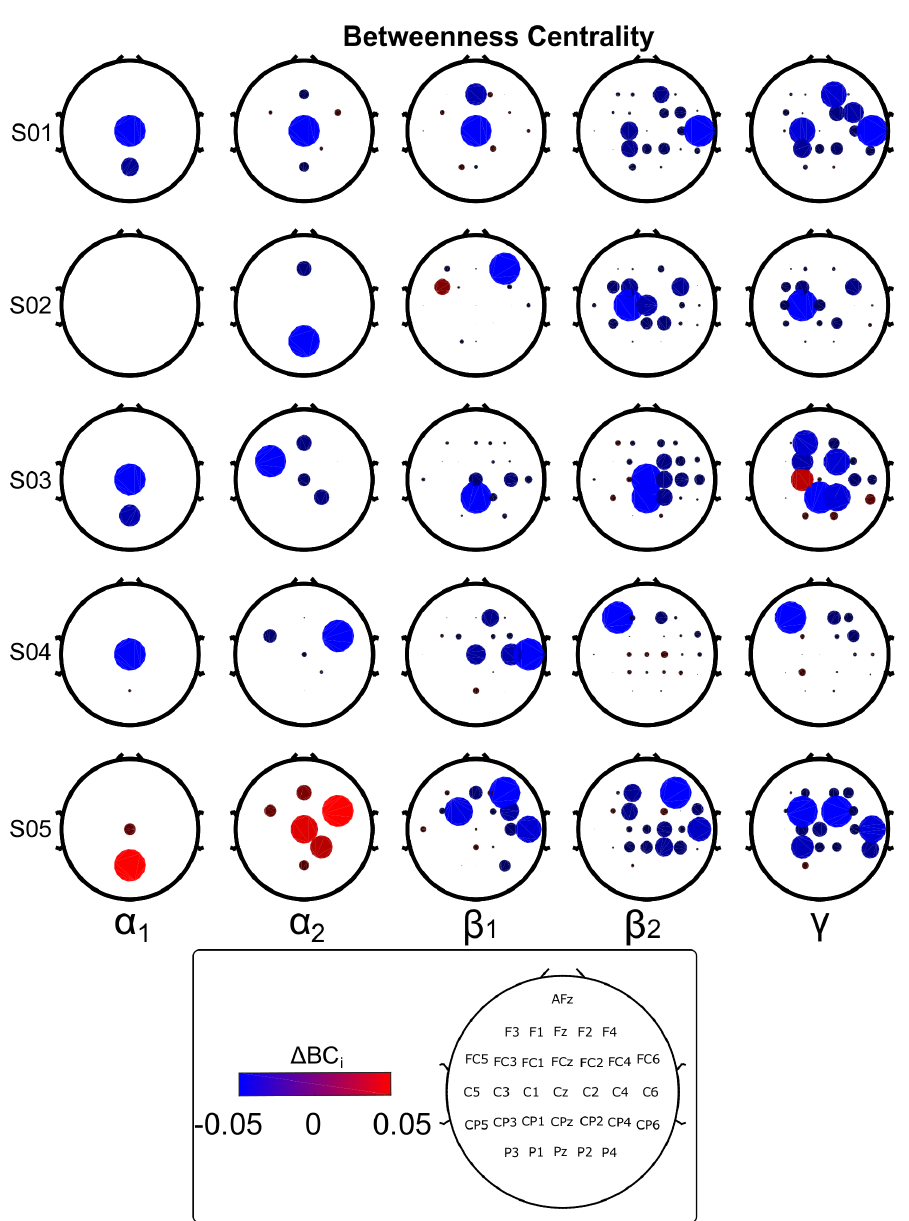
Figure 7. BC variations between pre- and post-intervention for all subjects and frequency bands; r = 0.75 and ρ = 0.30. Plotted radii are subject-specific. Only statistically significant variations are shown ( p < 0.00002; Wilcoxon